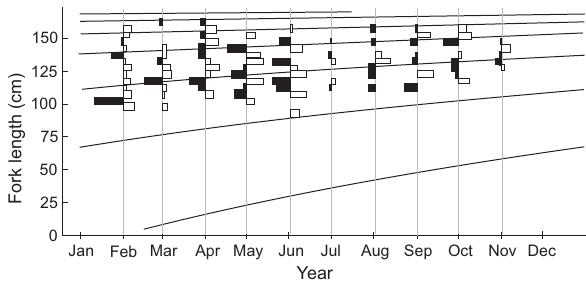
Figure 5. The von Bertalanffy growth curves of yellowfin tuna in the eastern and central Pacific Ocean as superimposed on the length-frequency histograms.